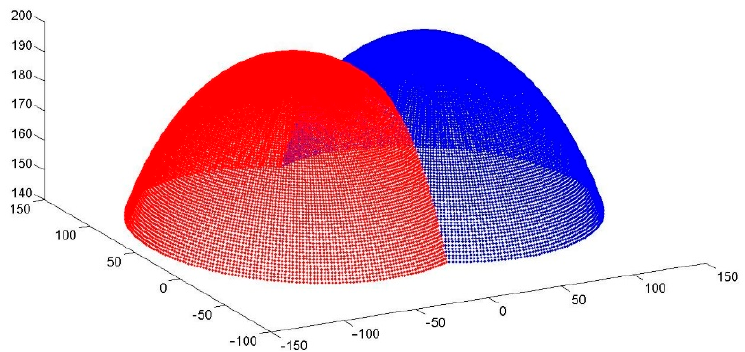
Figure 4. Workspace of a pair of flexible surgical instruments.